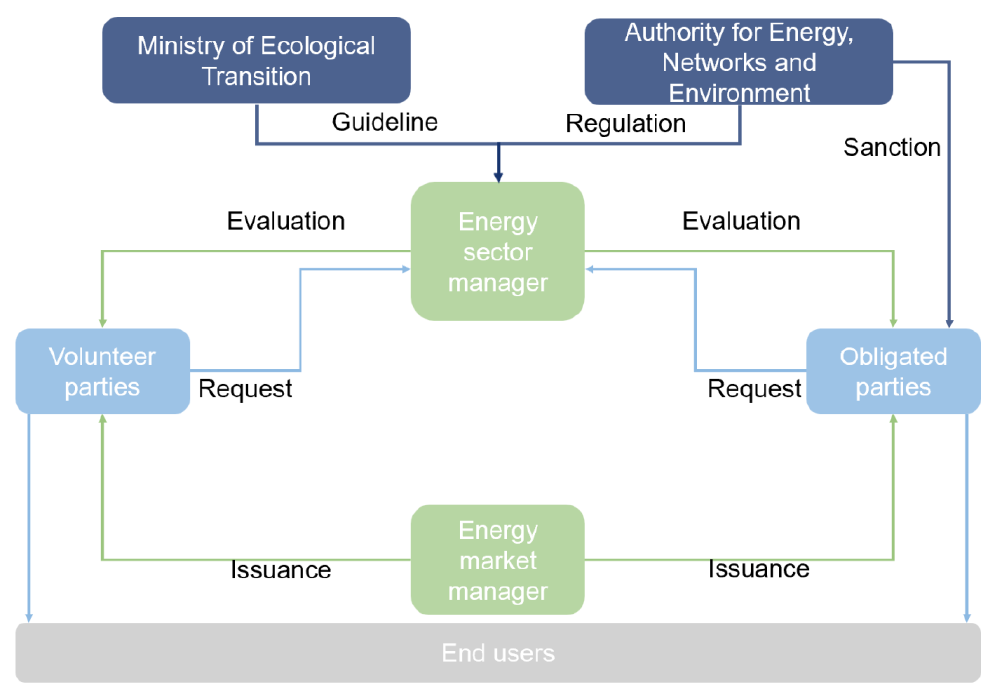
Figure 3. Outline of Italy’s white certificate scheme. Source: own elaboration based on [43].